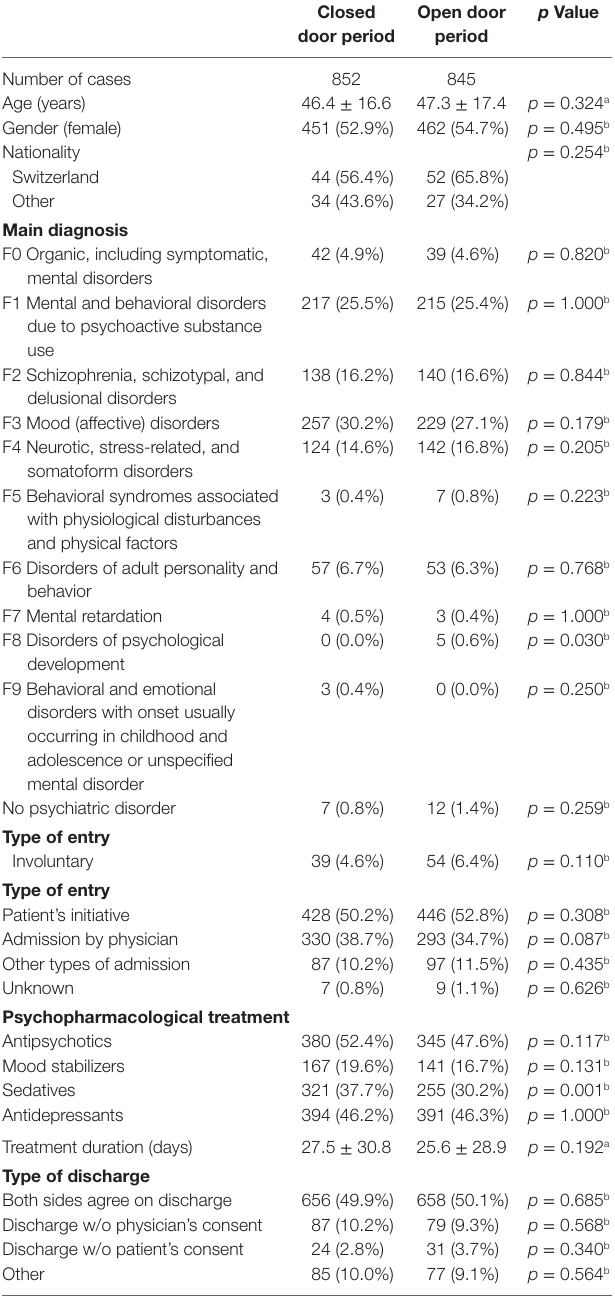
TaBle 2 | Clinical and sociodemographic characteristics of cases admitted to inpatient wards of the UPK Basel—except cases admitted to the PICU—before and after the introduction of predominantly open doors on the PICU ( N = 1,697).